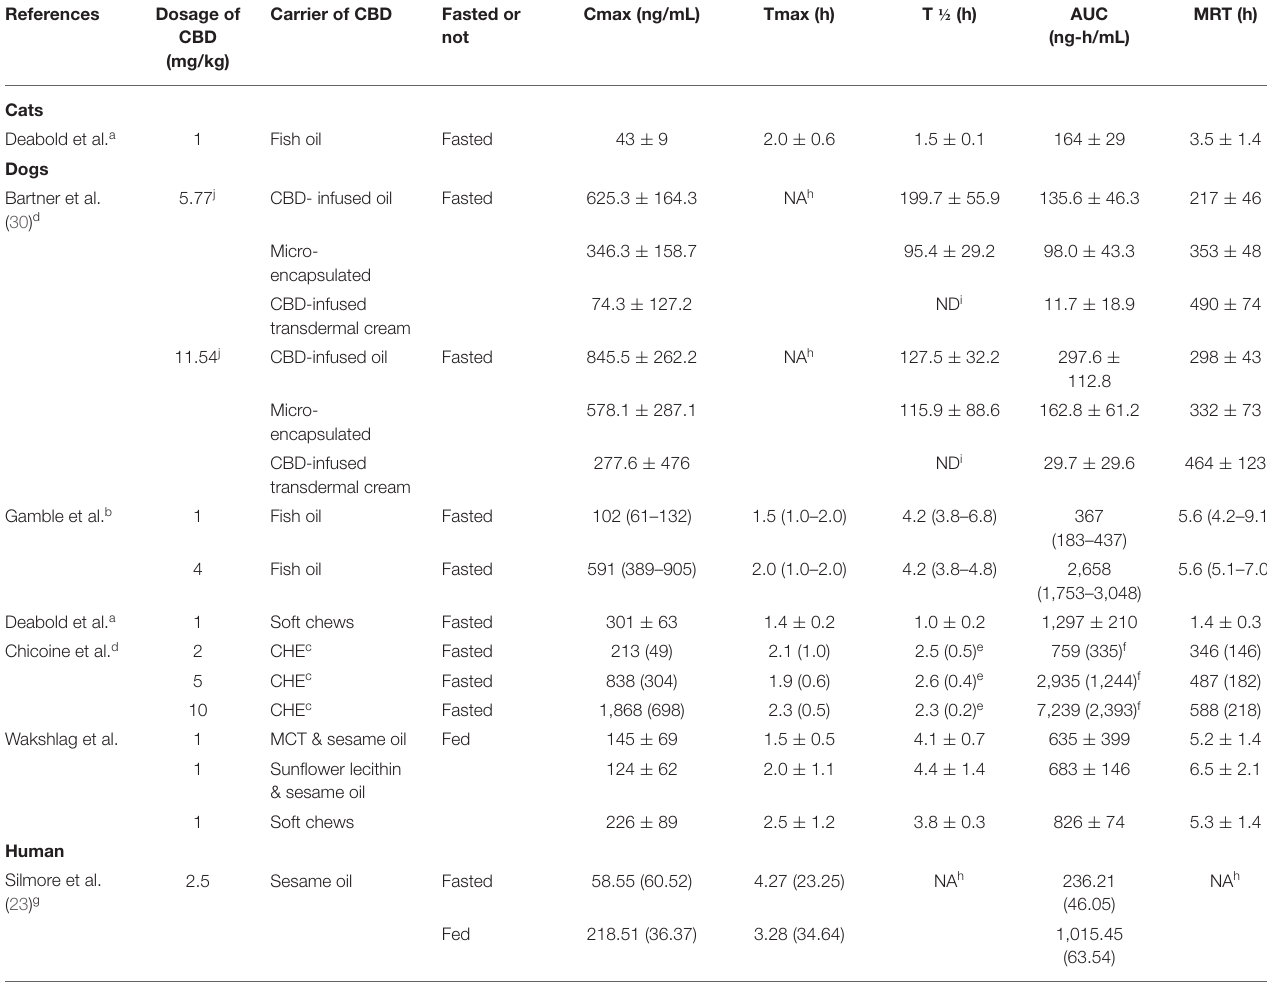
TABLE 4 | Comparison of Serum pharmacokinetic of single oral dosing CBD oil in previous